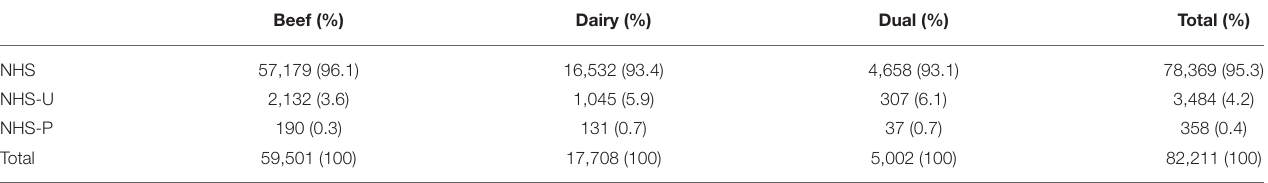
TABLE 6 | The number (%) of breeding herds assigned negative herd status (NHS), NHS-U a and NHS-P b overall and by herd type at the end of